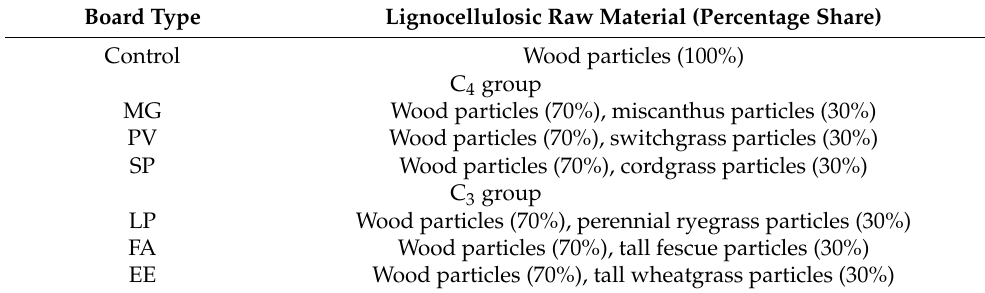
Table 4. Raw materials used in board